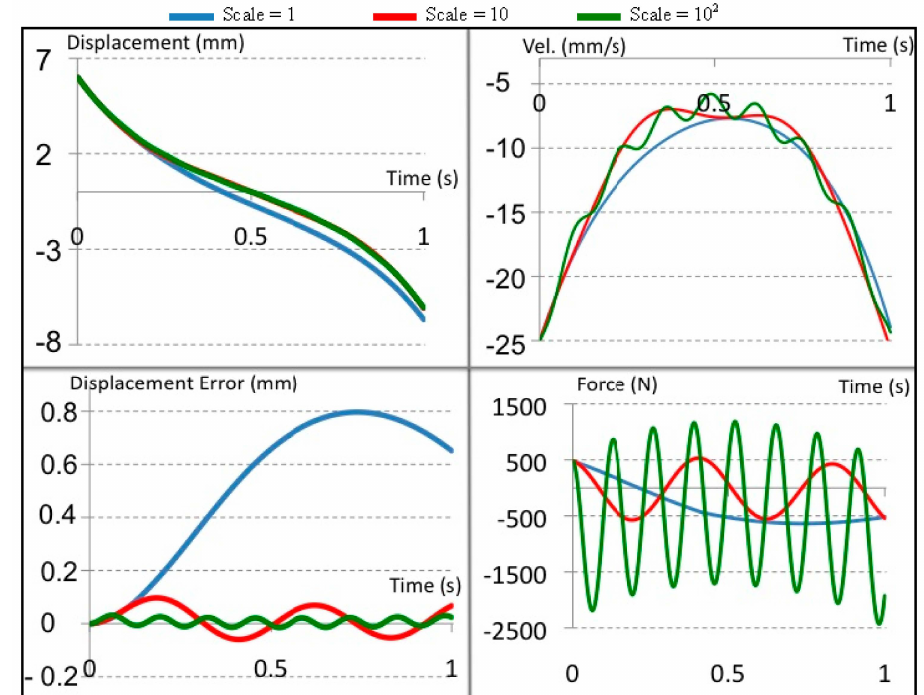
Figure 29. Simulation data for Slider motion during one-step walking in active mode. The data is for 3 experimental tests with different high stiffness scales. Low stiffness spring constant = 80 N/mm. High stiffness spring constant = 400 N/mm. ( a ) ankle pitch joint angle; ( b ) ankle pitch joint angular velocity; ( c ) ankle pitch joint torque; ( d ) CoM forward